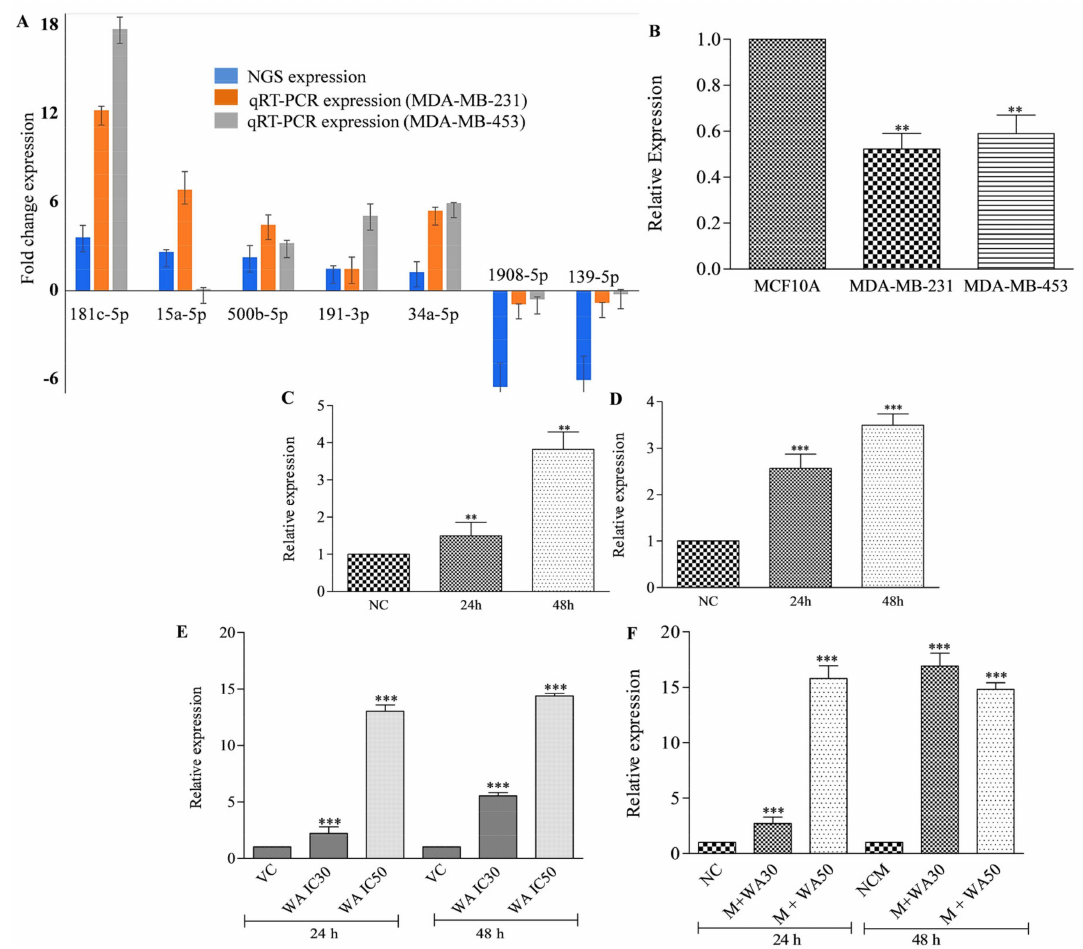
Figure 3. qRT-PCR expression analysis of differentially expressed miRNA(s). ( A ) Expression analysis of miRNAs in MDA-MB-231 and MDA-MB-453 cells using qRT-PCR technique compared with the next generation sequencing expression pattern. ( B ) Expression analysis of top differentially expressed miRNA (miR-181c-5p) in breast normal cells (MCF10A) and triple-negative breast cancer cells